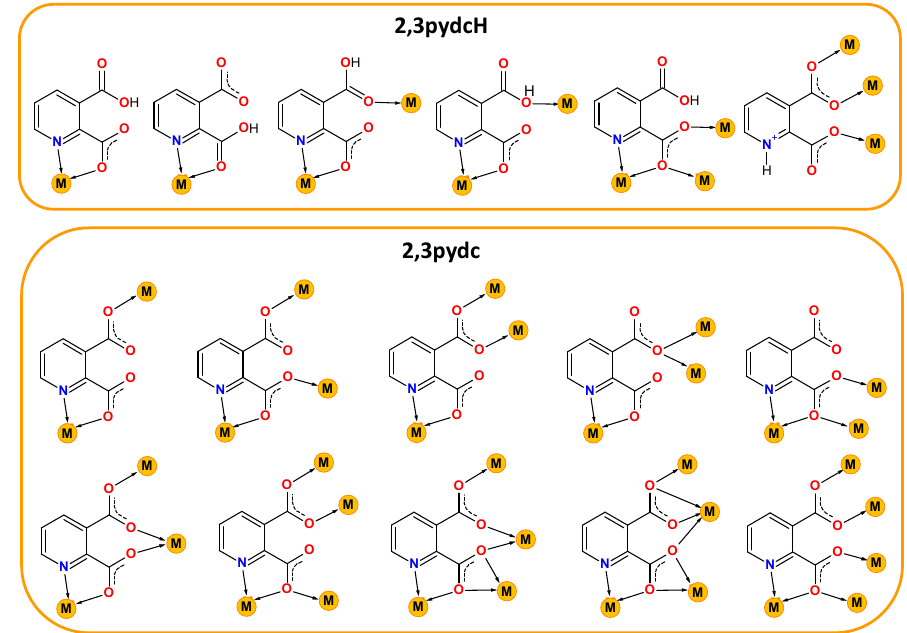
Scheme 1. Selected coordination modes of mono-deprotonated-2,3pydcH (top) and deprotonated- 2,3pydc (bottom) forms of pyridine-2,3-dicarboxylic acid (2,3pydcH 2 ) in coordination with di ff